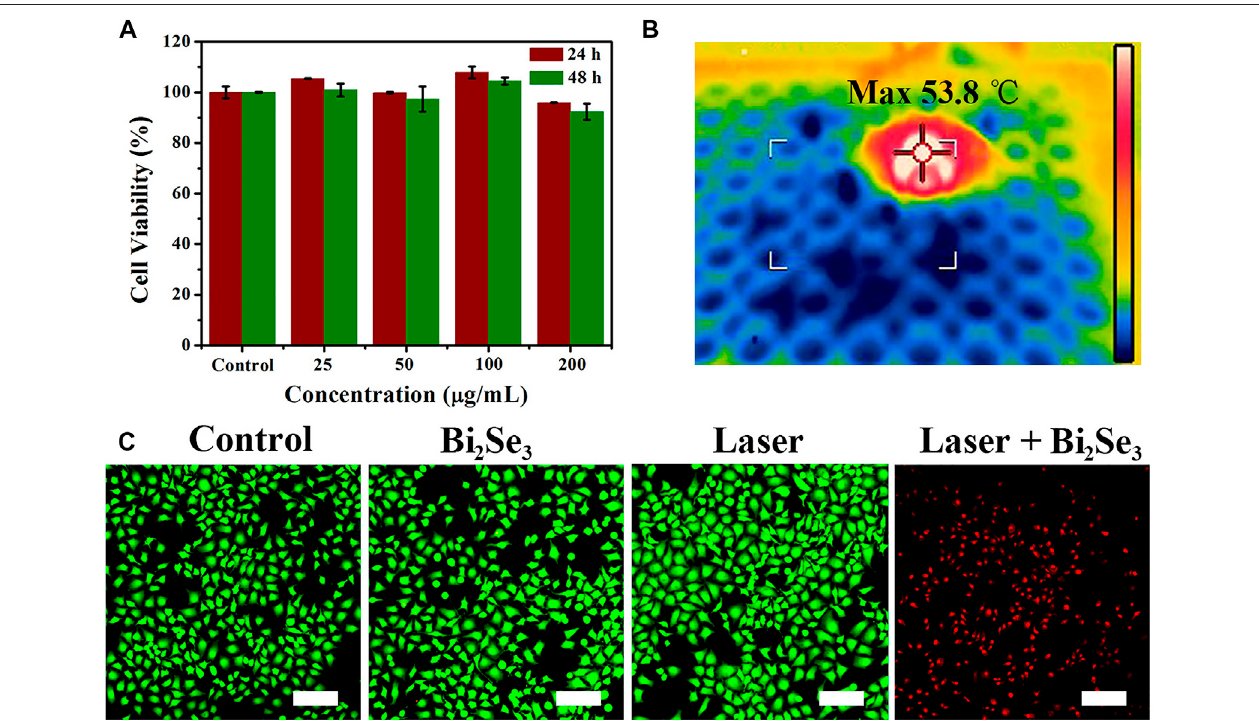
FIGURE 3 | (A) Viability of A549 cells incubated with PEI-Bi 2 Se 3 nanodots (0 – 200 μ g ml − 1 ) for 24 and 48 h (B) IR thermal images of A549 cells in a 96-well plate incubated with PEI-Bi 2 Se 3 nanodots after irradiation for 10 min (808 nm, 1.0 W cm − 2 ). (C) Fluorescence images of A549 cells stained with calcein-AM (live cells, green) and PI (dead cells, red) after various treatments. Scale bar (cid:1) 200 μ